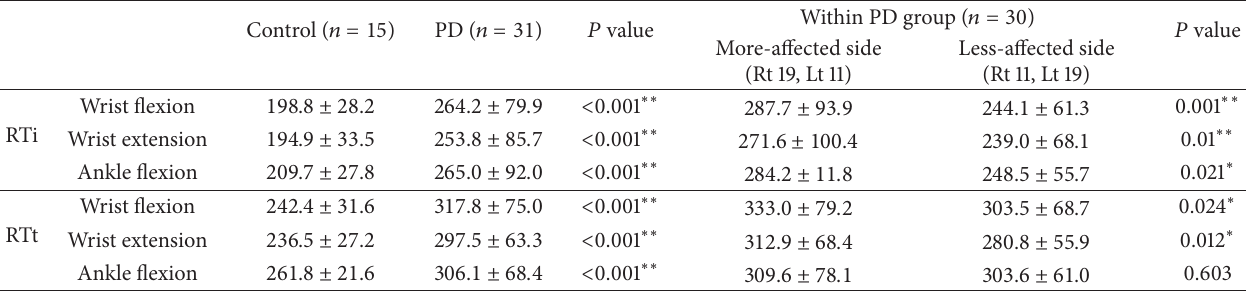
Table 1: Differences in reaction time between Parkinson’s disease patients ( 𝑛 = 31 ) and healthy controls based on independent 𝑡 -tests ( 𝑛 = 15 ) and paired 𝑡 -test comparison of the reaction times between the more- and less-affected side for all patients.